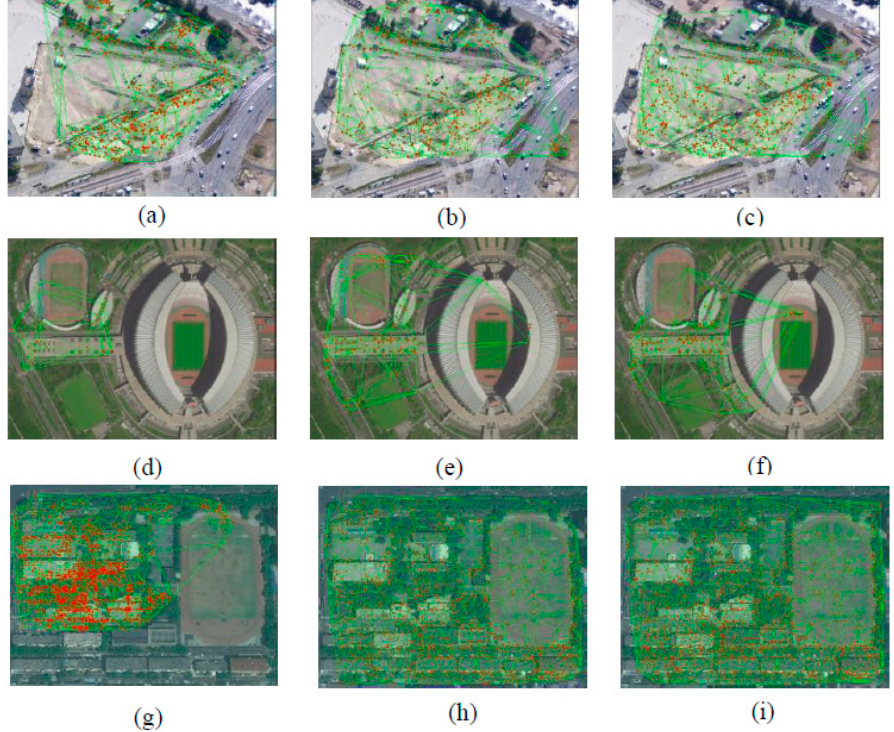
Figure 11. Delaunay triangulation network of matches from ground-based close-range stereo images JJ1–3. ( a , d , g ) tested on ASIFT. ( b , e , h ) tested on Brown-AffNet. ( c , f , i ) tested on SJRS-AffNet.